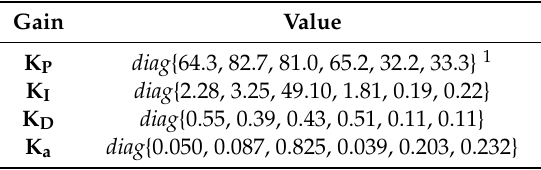
Figure 17. Inverse kinematic solution ( a ) without back-calculation and ( b ) with back-calculation. Table 2. Parameters of PID control algorithm with back ‐ calculation.